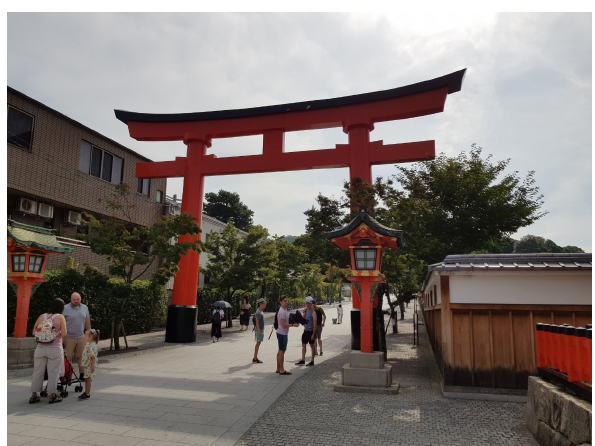
and the soundscape becomes more representative of typi-